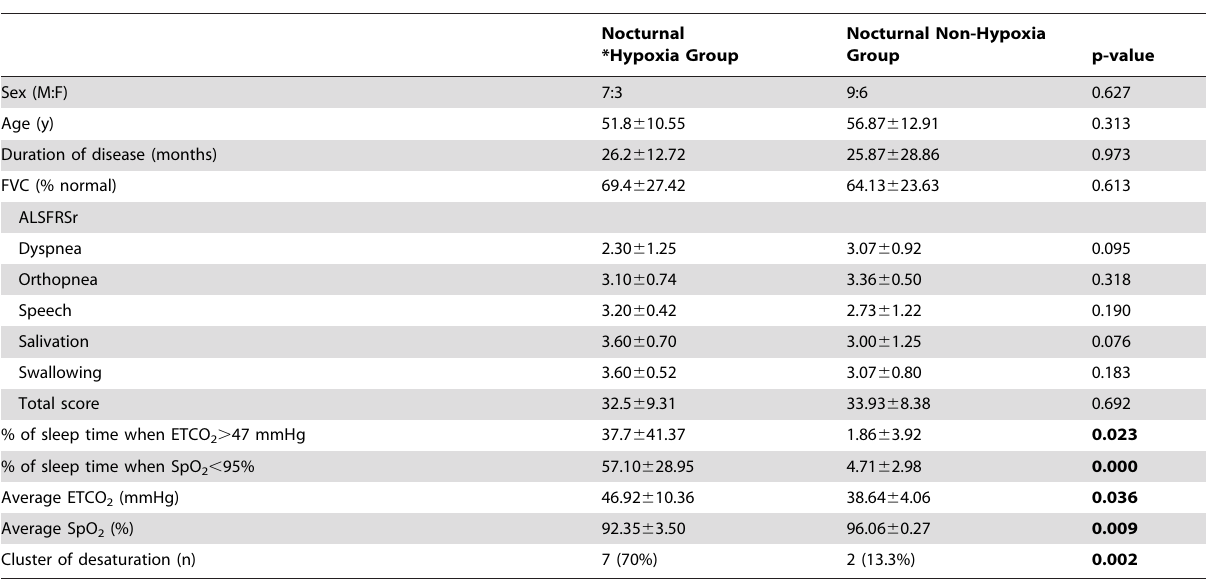
Table 1. Clinical and respiratory characteristics of the patients with